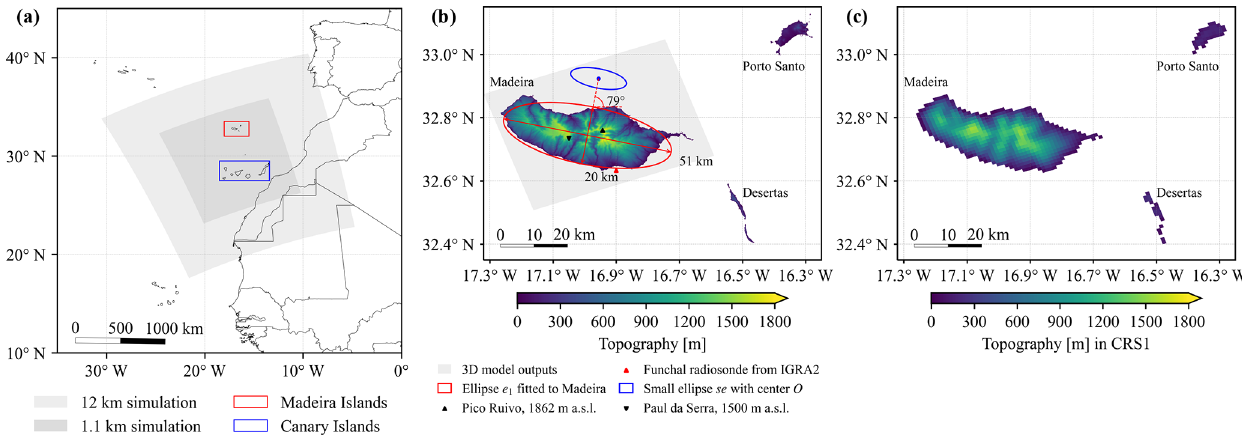
Figure 1. (a) The 12km (CPS12) and 1.1km (CRS1) COSMO model simulation domains and the location of the Madeira and Canary archipelagos. (b) Topography of the Madeira Archipelago with 30m horizontal resolution from the European Environmental Agency under the GMES RDA (Global Monitoring for Environment and Security Reference Data Access) project. The grey shading shows the region with decadal model outputs in all 60 (61) vertical model layers (levels). The Funchal radiosonde data from IGRA 2 (Integrated Global Radiosonde Archive) were used to calculate the inversion height. A red ellipse e 1 was fitted to the topography of Madeira using a Gaussian mixture model. The blue ellipse se was obtained by scaling e 1 to 1 / 9 of its area and then shifting along its minor axis for the length of its minor axis; se was employed to extract decadal 3D upstream conditions, which are only available within the grey-shaded area in (b) . It is important to mention that these upstream conditions cannot be assumed to be undisturbed due to the proximity of se to the island. The altitude of two mountain peaks indicated by black triangles is used to compare with the inversion height. (c) The topography with a horizontal grid spacing of 1.1km used in CRS1. The geographic map is from Natural Earth.